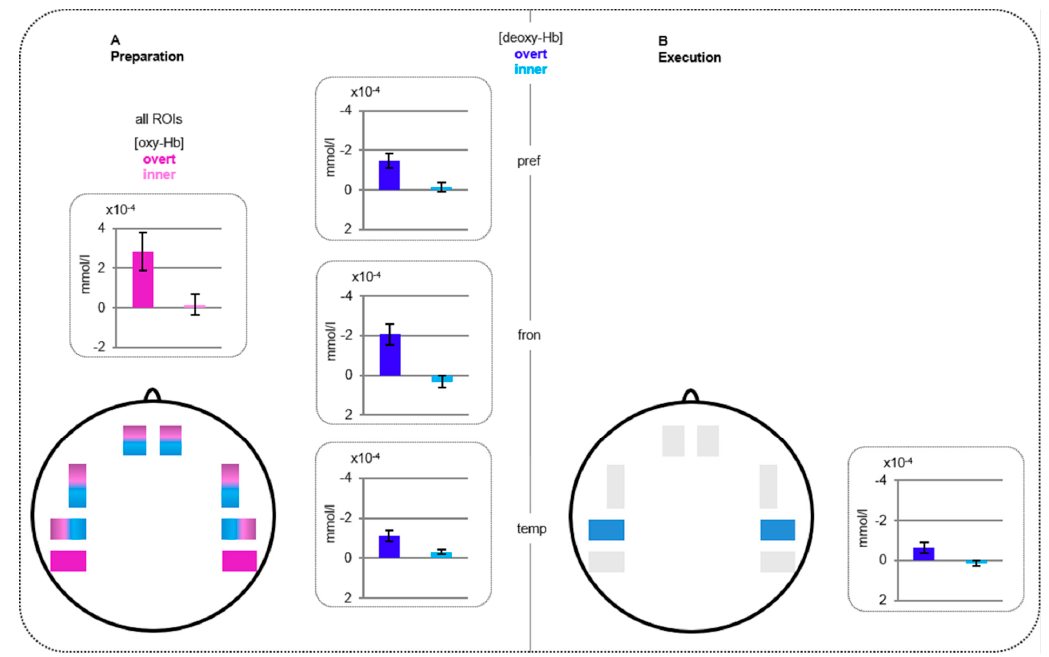
Figure 2. Functional near-infrared spectroscopy (fNIRS) results. Statistically significant differences between overt versus inner speech. ( A ) Beta-values for the preparation phase merged over all regions for oxy-hemoglobin (oxy-Hb; purple) and prefrontal, frontal, and temporal regions for deoxy-hemoglobin (deoxy-Hb; blue). ( B ) Beta-values for the execution phase at temporal regions for deoxy-Hb. Please note that a more positive value for oxy-Hb and a more negative value for deoxy-Hb (both plotted upwards here) are indications of increased activations.